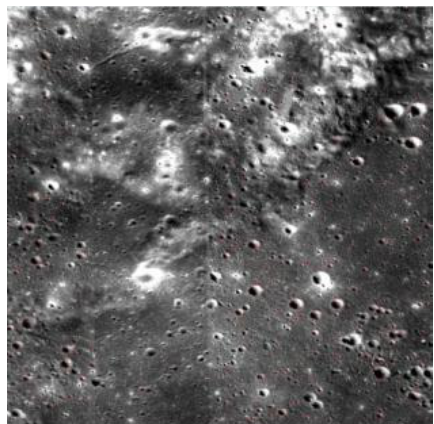
Figure 4. The result of extraction. The strip in the picture was obtained under different sunlight condition. As a result, some craters were not extracted in this paper. We just discuss wrong extraction. We do not take non extracted into consideration.